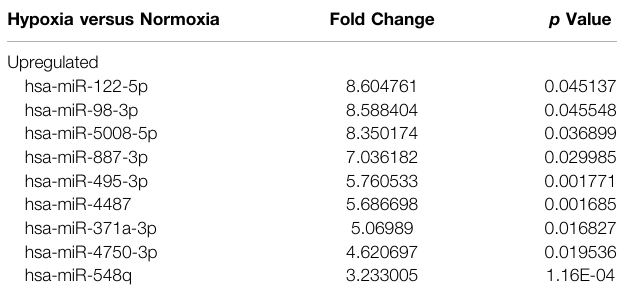
TABLE 2| Signi fi cantlydifferentially expressed EV-derived miRNAs underhypoxia for 24 h in HIEC